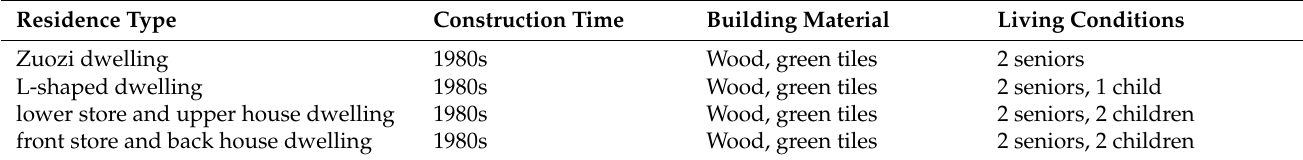
Table 4. Situation of monitored residential houses.